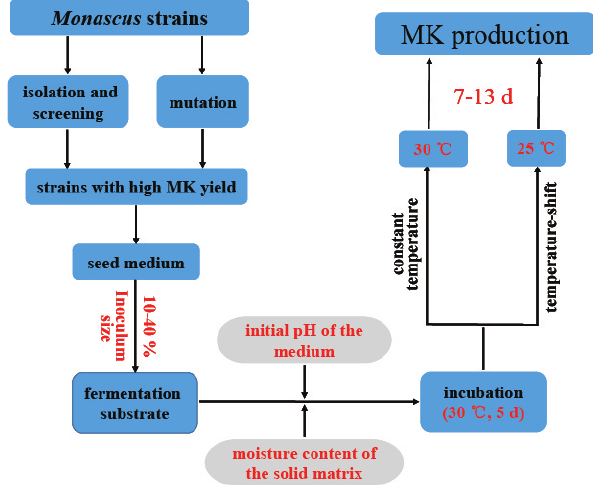
Figure 1 : The Process Chart of Monascus Fermentation for MK